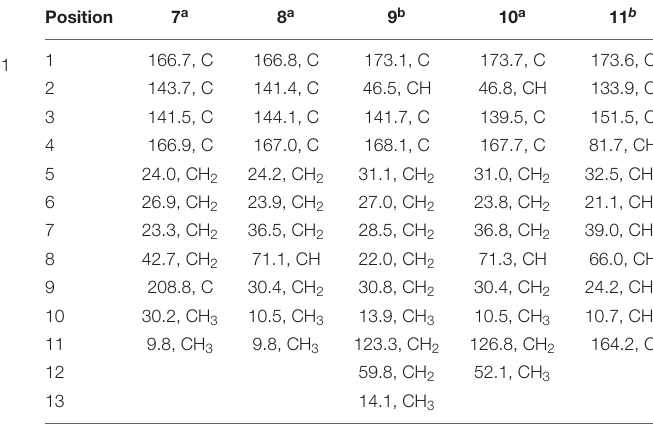
TABLE 2 | 13 C NMR data for compounds 7–11 ( δ in ppm) in DMSO- d 6